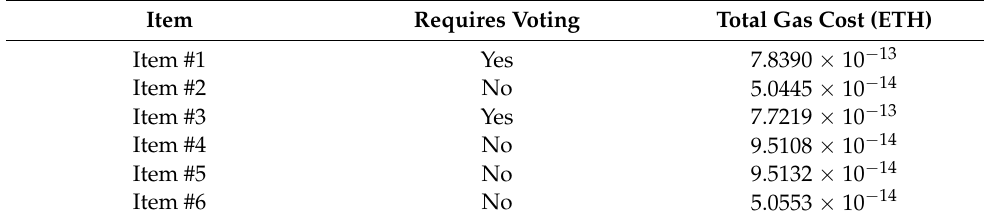
Table 3. Use case Scenario 1 total gas cost per item.